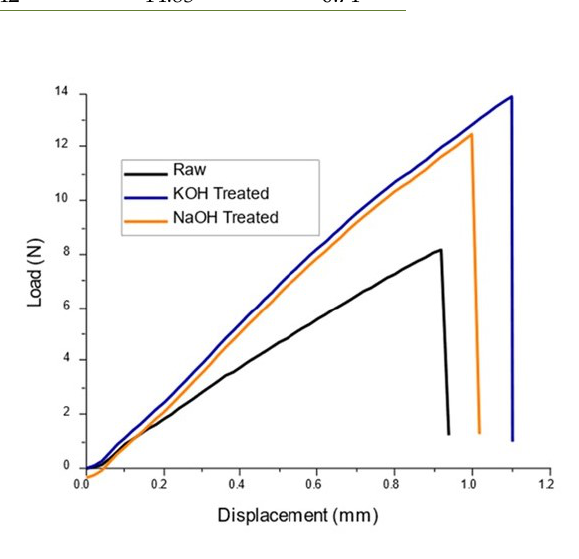
Fig. 6. Displacement-load of raw and treated